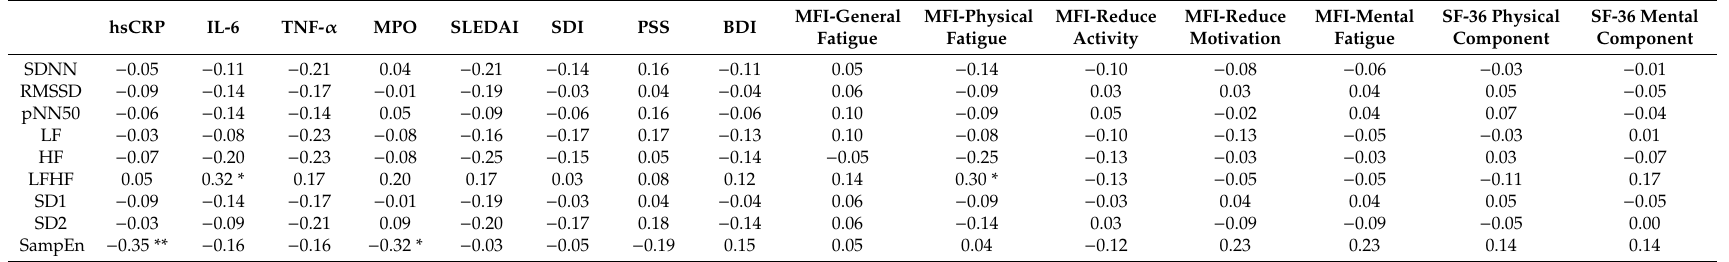
Table 3. Spearman’s correlations between HRV derived parameters, inflammatory markers, and PROs ( n =